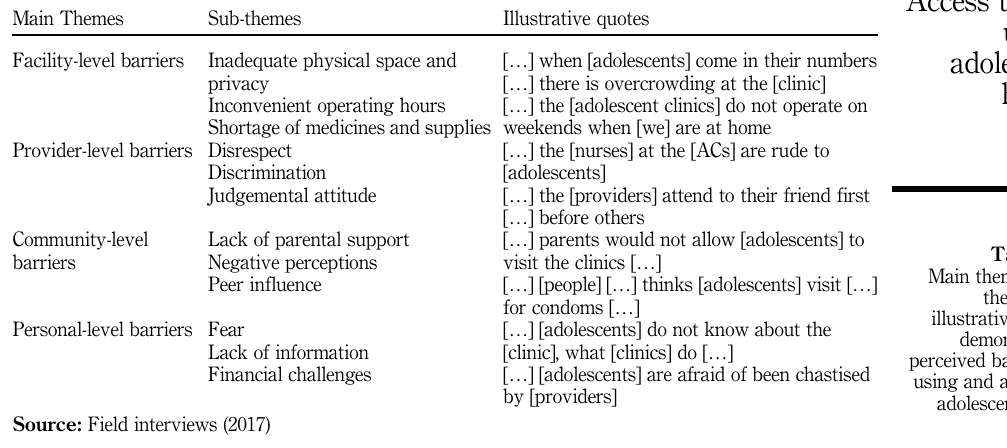
Table III. Main themes,